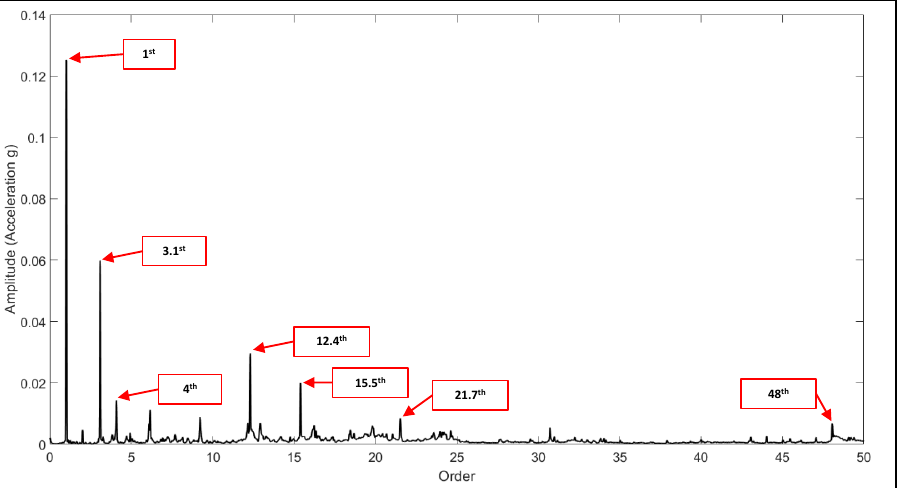
Figure 14. Average order spectrum of acceleration measured on the motor housing using a single-axis accelerometer.